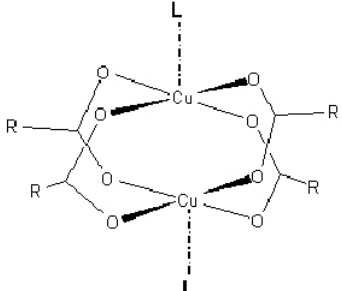
Figure 1. The paddle-wheel structure of copper(II)